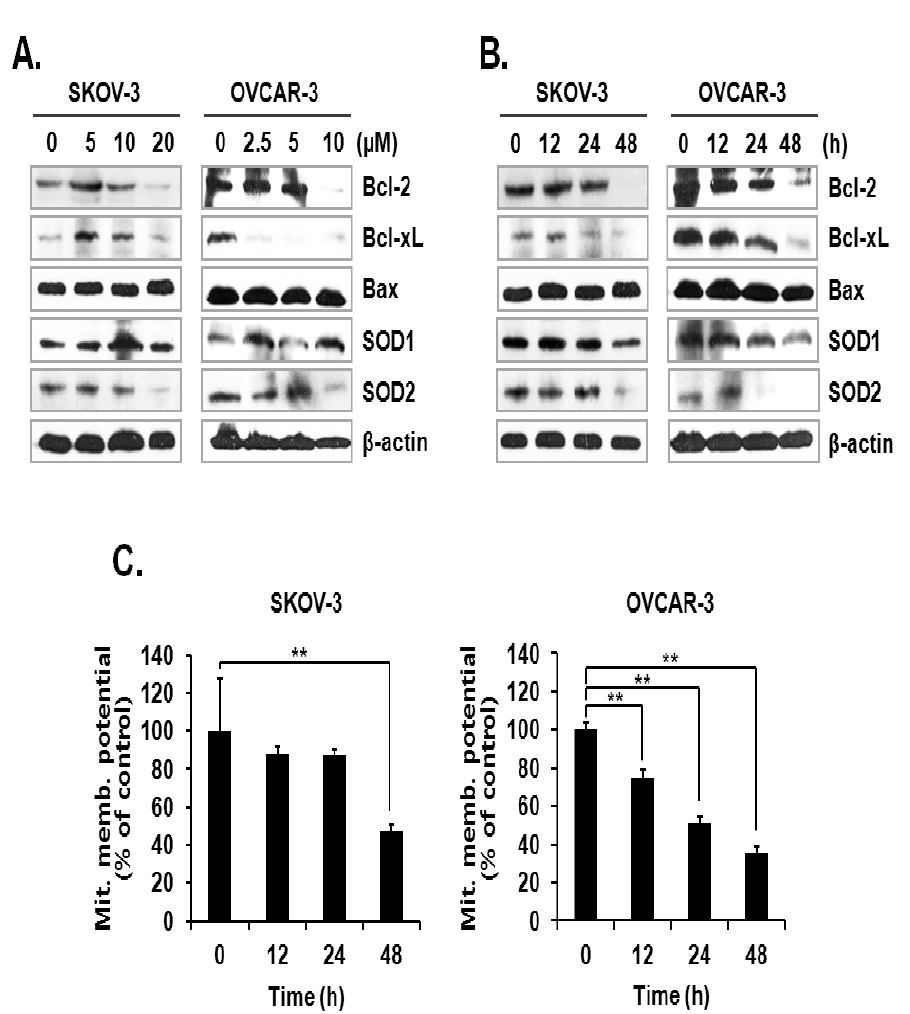
Figure 3. Loss of anti ‐ apoptotic Bcl ‐ 2 family proteins, SOD2, and MMP after ILL treatment. ( A , B ) ILL